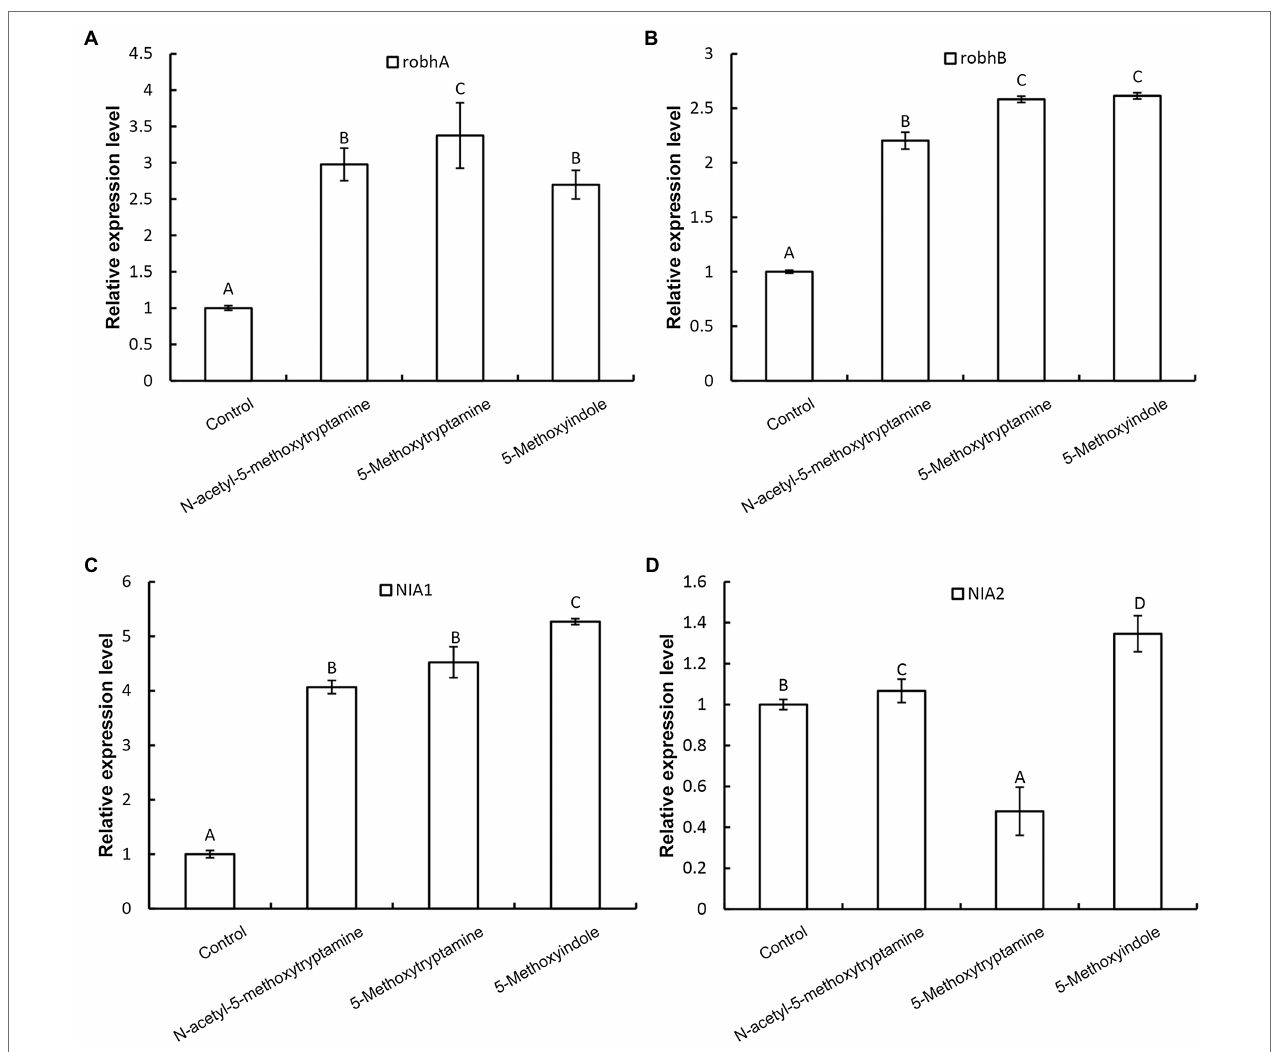
FIGURE 4 | Effect of melatonin, 5-methoxytryptamin, and 5-methoxyindoleregulate on the expression of genes involved in H 2 O 2 and NO production. The effect of MT and MT-homologs on the relative expression of genes involved in hydrogen peroxide and nitric oxide production. N. benthamiana plants were treated with water (control) or 50 μ M solutions of MT, 5-methoxytryptamine, or 5-methoxyindole. The expression level of robhA (A) , robhB (B) , NIA1 (C) , and NIA2 (D) gene in leaves was determined by RT-qPCR. Data are mean ± standard deviation (SDs; n = 9) of three independent experiments. Columns with different letters indicate a significant difference ( p ≤ 0.01) between the treatment groups as determined by a Duncan’s multiple range